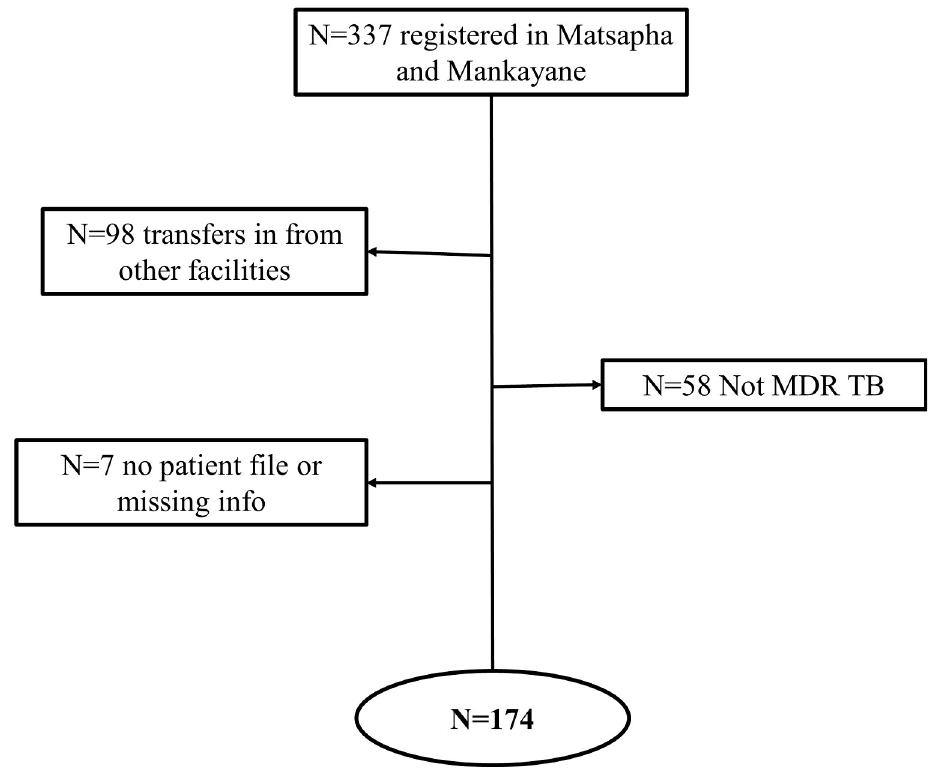
Fig 1. Patients inclusion flow